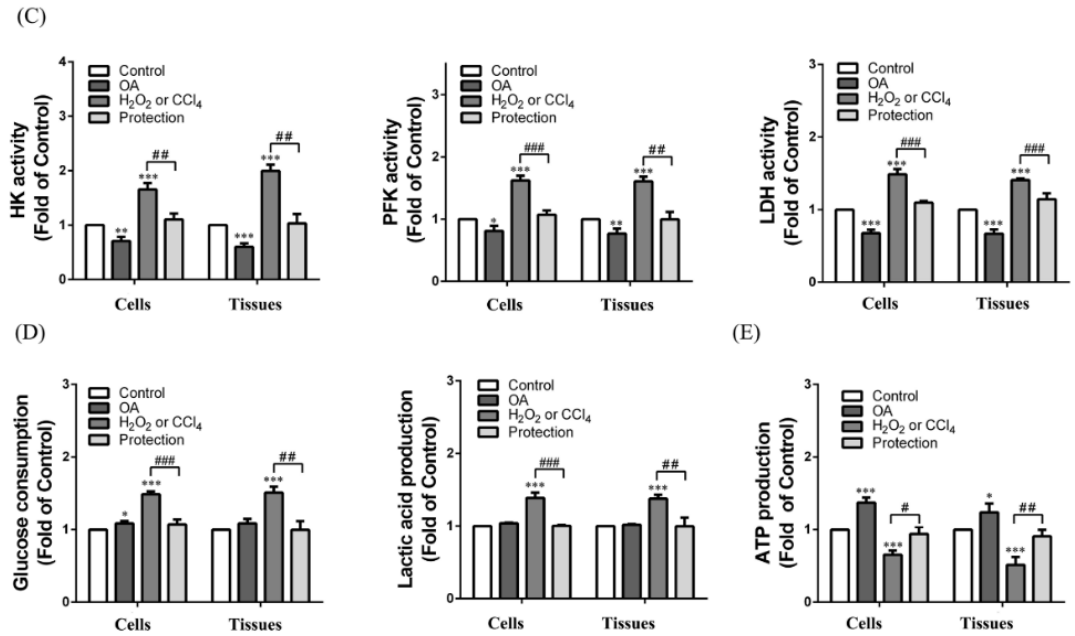
Figure 4. Effect of OA on glycolysis. ( A ) The enrolled genes were conducted the unsupervised hierarchical clustering with edgeR Package (left panel). Partial kyoto encyclopedia of genes and genomes (KEGG) pathway enrichment (right panel); ( B ) The column diagram represents mRNA expression levels of different glycolytic genes (CCl 4 vs. Control); ( C ) The enzymatic activity of hexokinase (HK), phosphofructokinase (PFK), and lactate dehydrogenase (LDH) in the cells and tissues. Groups were as described in “Methods: Cell line and Reagents, animals”; ( D ) Glucose consumption and lactic acid production in the LO-2 cells and tissues. Group were as described in “Methods: Cell line and Reagents, animals”; ( E ) ATP production in the LO-2 cells and tissues. Groups were as described in “Methods: Cell line and Reagents, animals”. The experiments were repeated at least three times. The results are presented as the mean ± SD. * p < 0.01, ** p < 0.01, *** p < 0.001 compared with the control. # p < 0.05, ## p < 0.01, ### p < 0.001 compared with the H 2 O 2 or CCl 4 group.